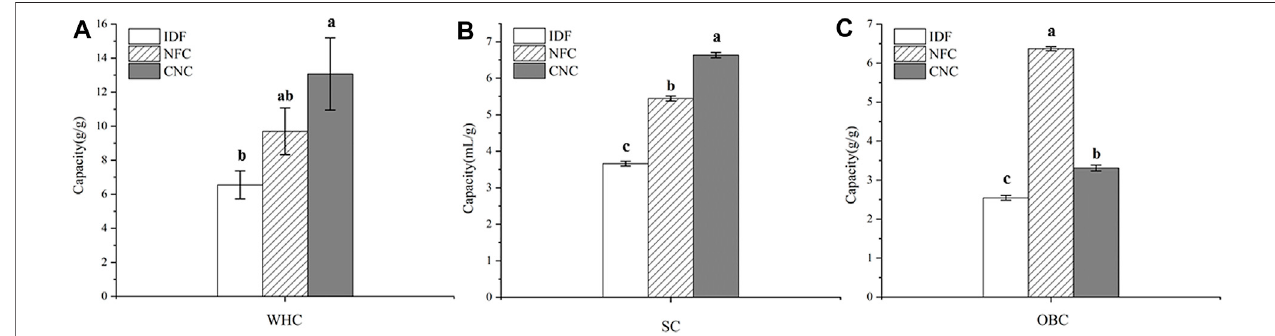
FIGURE 6 | Physicochemical properties of bamboo shoot IDF, NFC, and CNC. (A) Water holding capacity, (B) swelling capacity, and (C) oil holding capacity.